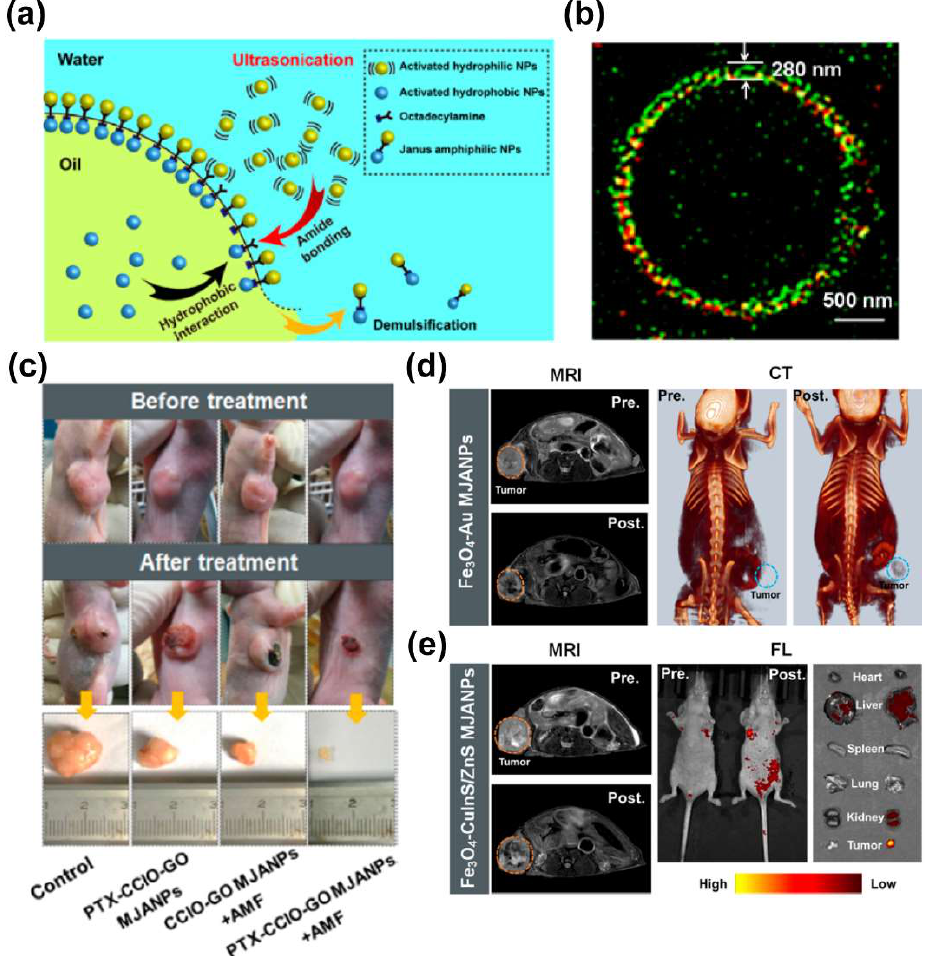
Figure 6. ( a ) Schematics of the ultrasonatically triggered interfacial assembly process. ( b ) SIM image of the Pickering emulsion. Fluoresceinamine was used to label graphene oxide nanosheets (green), and rhodamine B isothiocyanate (RITC) was used to label Co cluster–embedded IONPs (red). ( c ) Photographs of pre– and post–MHT treatment mice. ( d ) In vivo T2–weighted MRI and CT images of tumor–bearing mice pre– and post–injection of Au NPs−MIONs MJANPs. Arrowheads indicate the tumor. ( e ) In vivo T2–weighted MRI and fluorescence images of tumor–bearing nude mice pre– and postinjection of CuInS/ZnS−MIONs MJANPs. Arrowheads indicate the tumor. Reprint with permission from [16]. Copyright 2019 American Chemical Society.